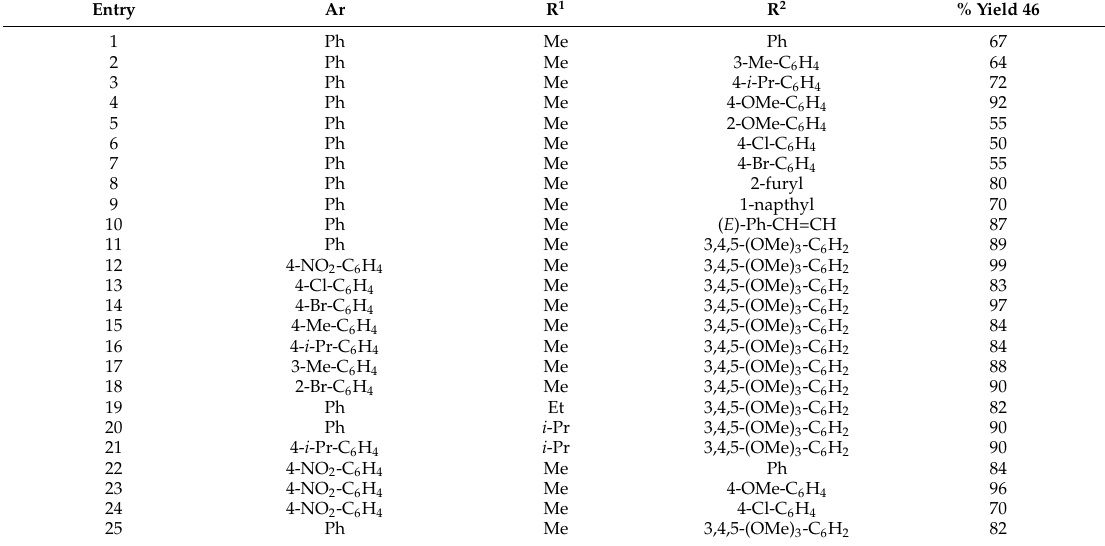
Table 5. Cycloaddition of azomethine ylides 45 to aldehydes 2 catalyzed by nickel(II) perchlorate (Scheme 9).